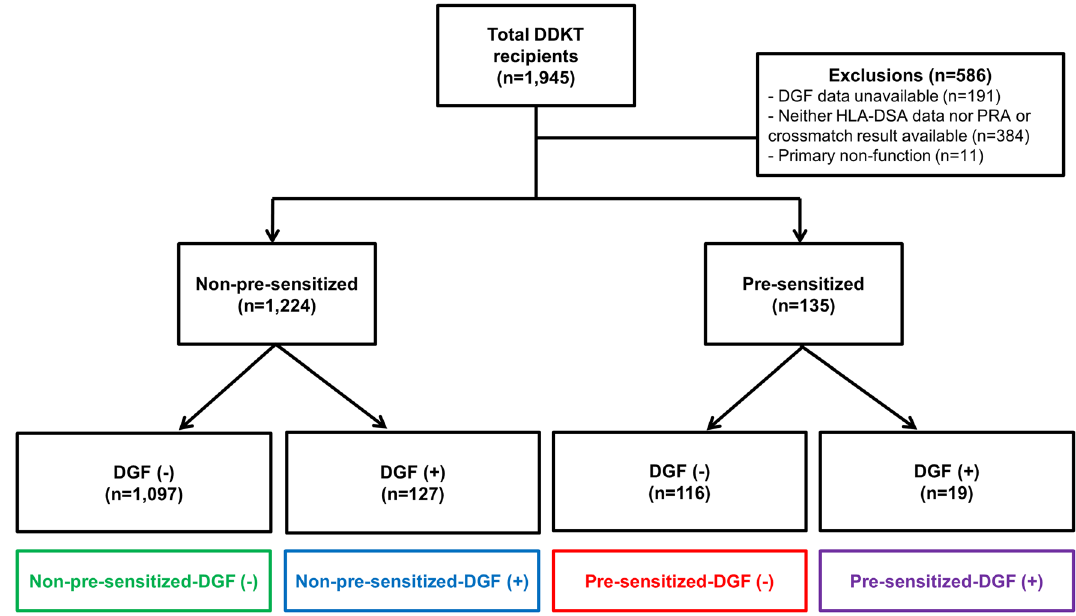
Figure 4. Distribution of the patient population according to DGF or pre-sensitization to HLA. DGF delayed graft function, HLA human leukocyte antigen, DDKT deceased donor kidney transplantation, DSA donor- specific